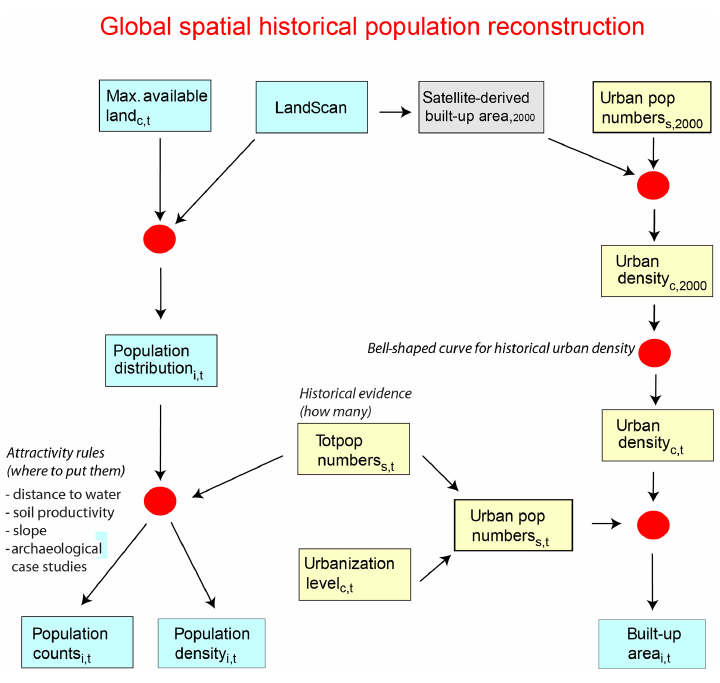
Figure 1. Population allocation